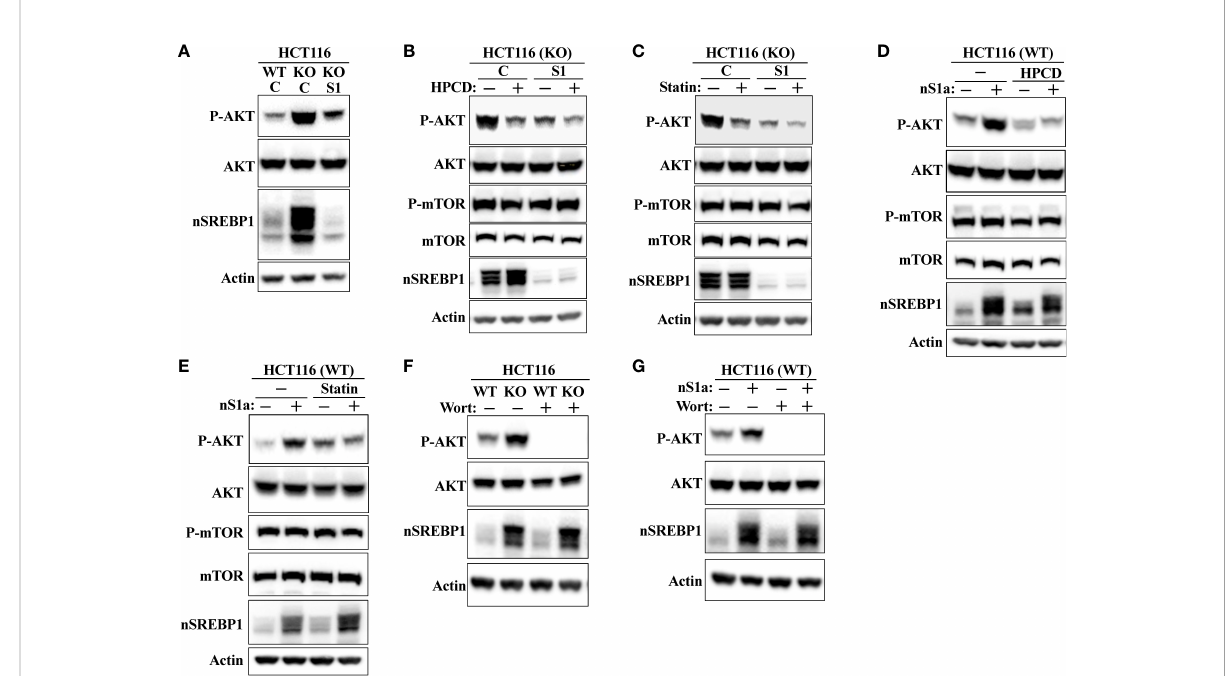
FIGURE 8 SREBP1 is required for the activation of AKT in response to Fbw7 loss. (A) Wild-type ( WT ) and Fbw7 knockout ( KO ) HCT116 cells were transduced with either control ( C ) or SREBP1 ( S1 ) shRNA, lysed and the levels of AKT, nuclear SREBP1 ( nSREBP1 ), b -actin, and the phosphorylation of AKT on Ser473 ( P-AKT ) were determined by Western blotting. (B) Fbw7 knockout ( KO ) HCT116 cells were transduced with either control ( C ) or SREBP1 ( S1 ) shRNA and either left untreated (-) or treated ( + ) with HPCD for 2 hours, lysed and the levels of AKT, nuclear SREBP1 ( nSREBP1 ), mTOR, b -actin, and the phosphorylation of AKT on Ser473 ( P-AKT ) and mTOR on Ser2448 ( P-mTOR ) were determined by Western blotting. (C) Wild-type and Fbw7 knockout ( KO ) HCT116 cells were transduced with either control ( C ) or SREBP1 ( S1 ) shRNA and left untreated (-) or treated ( + ) with fl uvastatin ( Statin ) for 12 hours (2 m M). The cells were lysed and the levels of AKT, mTOR, nuclear SREBP1 ( nSREBP1 ), b -actin, and the phosphorylation of AKT on Ser473 ( P-AKT ) and mTOR on Ser2448 ( P-mTOR ) were determined by Western blotting. (D) Wild-type ( WT ) HCT116 cells were transduced with either GFP or nuclear SREBP1a ( nS1a ) and left untreated (-) or treated (+) with HPCD for 2 hours. The cells were lysed and the levels of AKT, mTOR, nuclear SREBP1 ( nSREBP1 ), b -actin, and the phosphorylation of AKT on Ser473 ( P-AKT ) and mTOR on Ser2448 ( P-mTOR ) were determined by Western blotting. (E) Wild-type ( WT ) HCT116 cells were transduced with either GFP or nuclear SREBP1a ( nS1a ) and left untreated (-) or treated ( + ) with fl uvastatin ( Statin ) for 12 hours (2 m M). The cells were lysed and the levels of AKT, mTOR, nuclear SREBP1 ( nSREBP1 ), b -actin, and the phosphorylation of AKT on Ser473 ( P-AKT ) and mTOR on Ser2448 ( P-mTOR ) were determined by Western blotting. (F) Wild-type ( WT ) and Fbw7 knockout ( KO ) HCT116 cells were left untreated (-) or treated ( + ) with wortmannin ( Wort , 200 nM) for 1 hour. The cells were lysed and the levels of AKT, nuclear SREBP1 ( nSREBP1 ), b -actin, and the phosphorylation of AKT on Ser473 ( P-AKT ) were determined by Western blotting. (G) Wild-type ( WT ) HCT116 cells were transduced with either GFP or nuclear SREBP1a ( nS1a ) and treated as in ( F ). The cells were lysed and the levels of AKT, nuclear SREBP1 ( nSREBP1 ), b -actin, and the phosphorylation of AKT on Ser473 ( P-AKT ) were determined by Western